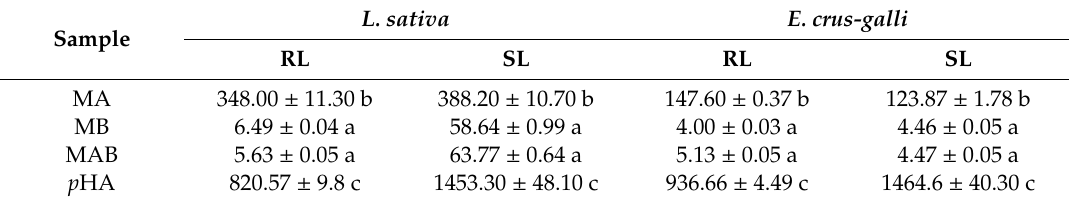
Table 2. IC 50 value ( µ g / mL) for inhibitory e ff ect of MA and B on growth of L. sativa and E. crus-galli